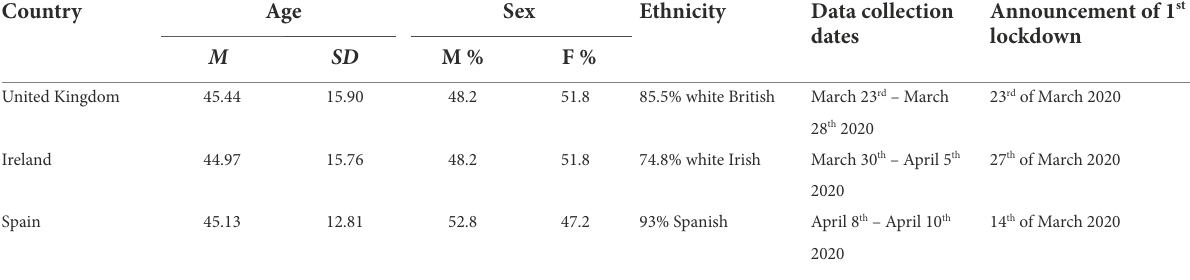
TABLE 1 Sample characteristics, mean ( M) standard deviation (SD) and percentages of sex distribution and ethnicity. Country Age Sex